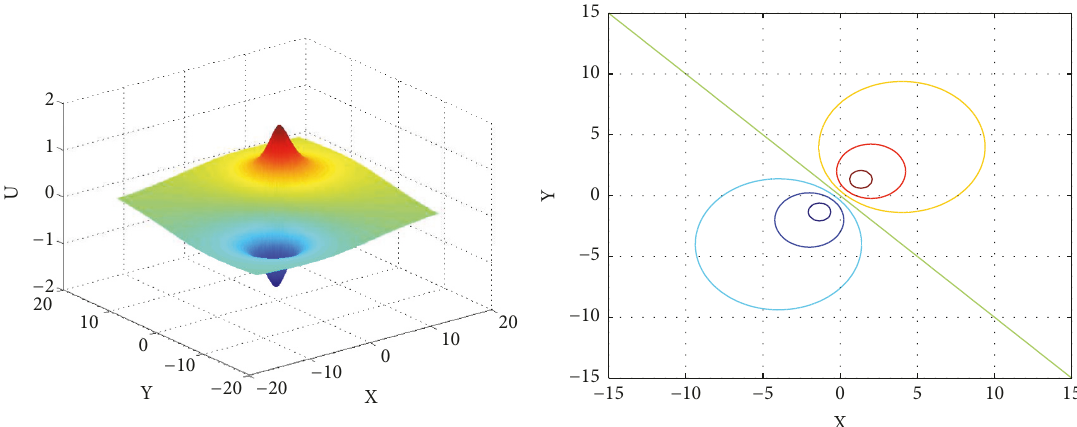
Figure 2: The 3D plot of lump (18) and the corresponding contour